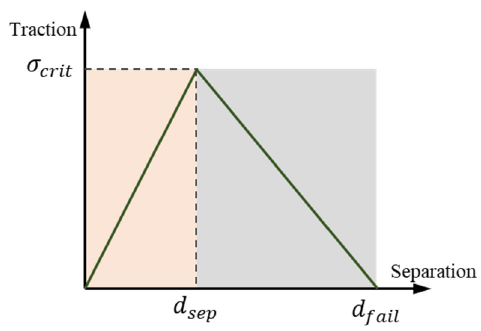
Figure 4. Typical traction–separation response.